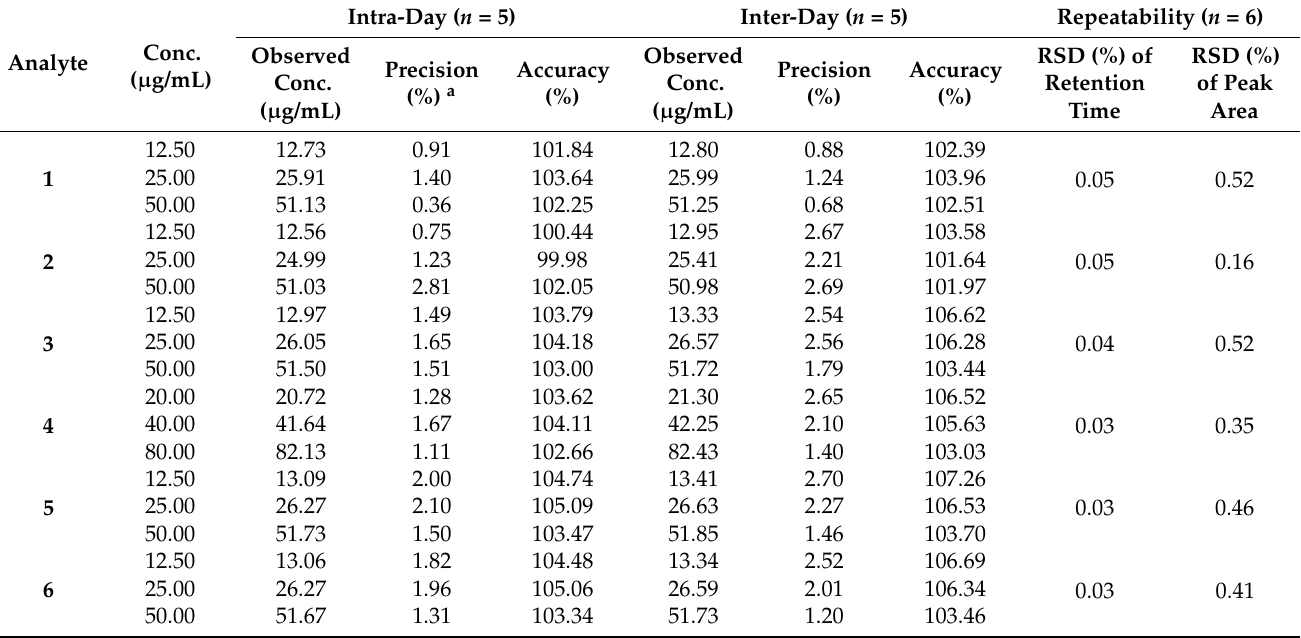
Table 3. Precision validation of compounds 1 – 18 in the developed analytical